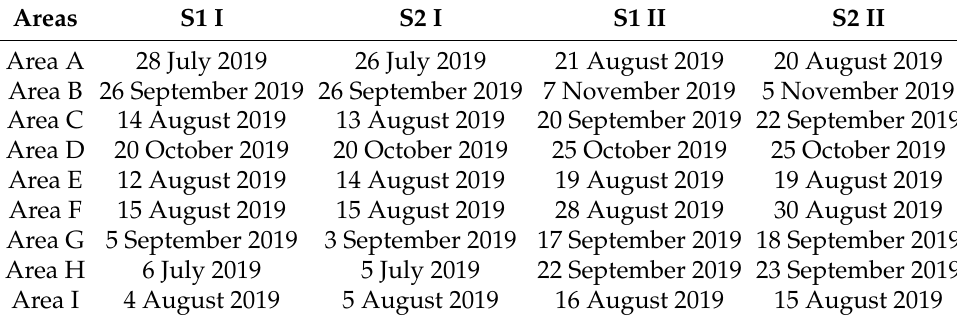
Table A7. The time of Sentinel-1/Sentinel-2 image pairs for different